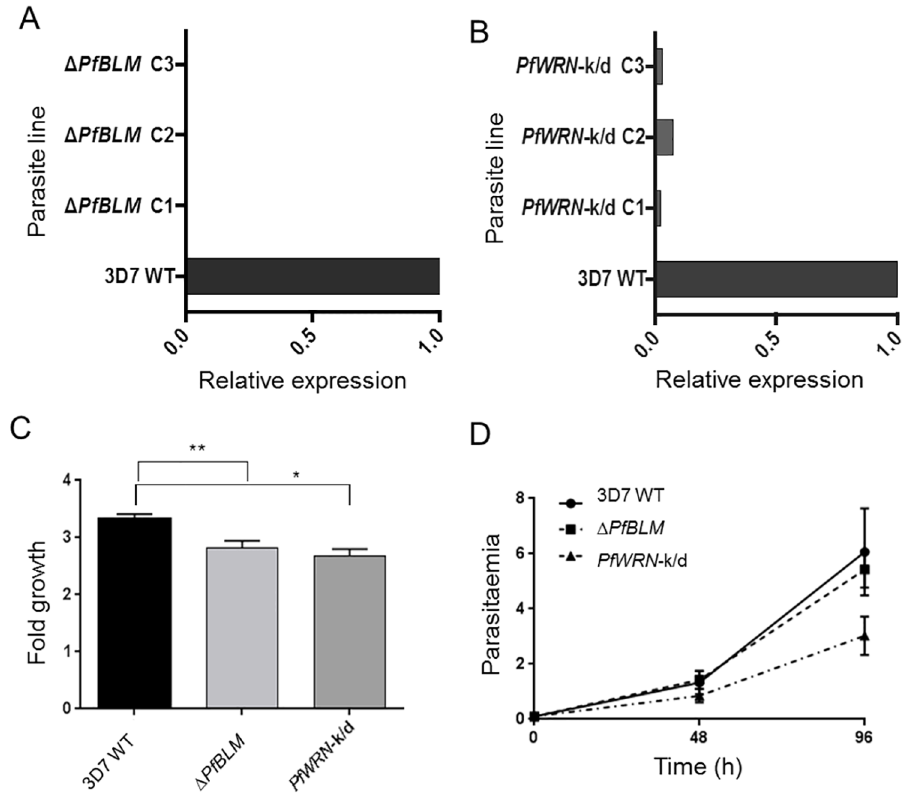
Fig 1. Loss of RecQ helicases affects parasite growth. (A) PfBLM expression in a panel of Δ PfBLM clones compared to wildtype 3D7 parasites. PfBLM transcript levels were determined by real-time PCR analysis using primer pair PfBLM_F/R .In each clone, relative expression of PfBLM was calculated by comparison to the control gene seryl-tRNA- synthetase. In the wildtype 3D7 line this relative expression level was set to 1 and PfBLM expression in each clone was then expressed as a fraction of this level. PCR was carried out in technical duplicate and the complete lack of PfBLM expression in Δ PfBLM clones was confirmed by agarose gel electrophoresis of PCR reaction products. (B) PfWRN expression in a panel of PfWRN -k/d clones compared to wildtype 3D7 parasites. Primer pair PfWRNjp2F/R , which spans a region of the PfWRN locus that should be absent if gene replacement via double homologous recombination had occurred, was used to detect PfWRN expression. Seryl-tRNA-synthetase and fructose bisphosphate aldolase were used as control genes for normalisation, with PfWRN expression being calculated by comparison to the mean expression level of these two genes. As in (A), relative PfWRN expression was then set to 1 in the wildtype 3D7 control and expression in each clone was expressed as a fraction of this level. PCR was carried out in technical duplicate and the low level of PfWRN expression in PfWRN -k/dclones was confirmed by agarose gel electrophoresis. (C) Parasite growth in the Δ PfBLM , PfWRN -k/d and parent lines, assessed by a standard 48h growth assay. Mean of three biological replicates, each conducted in technical triplicate, is shown; error bars are standard error of the mean and statistical significance was determined using one-tailed t-tests ( (cid:3) , p < 0.05; (cid:3)(cid:3) , p < 0.01). (D) Parasite growth counted at 48h intervals over two growth cycles in the Δ PfBLM , PfWRN -k/d and parent lines, after seeding parasites at 0.1% parasitaemia. Mean growth in three biological replicates, each conducted in technical triplicate, is shown; error bars are standard error of the